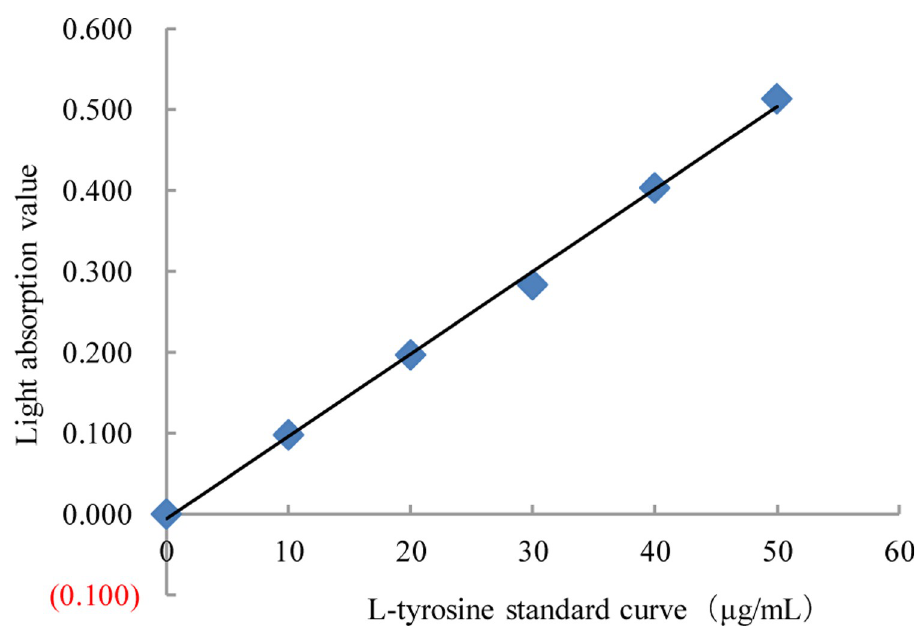
Fig 1. L-tyrosine standard curve.